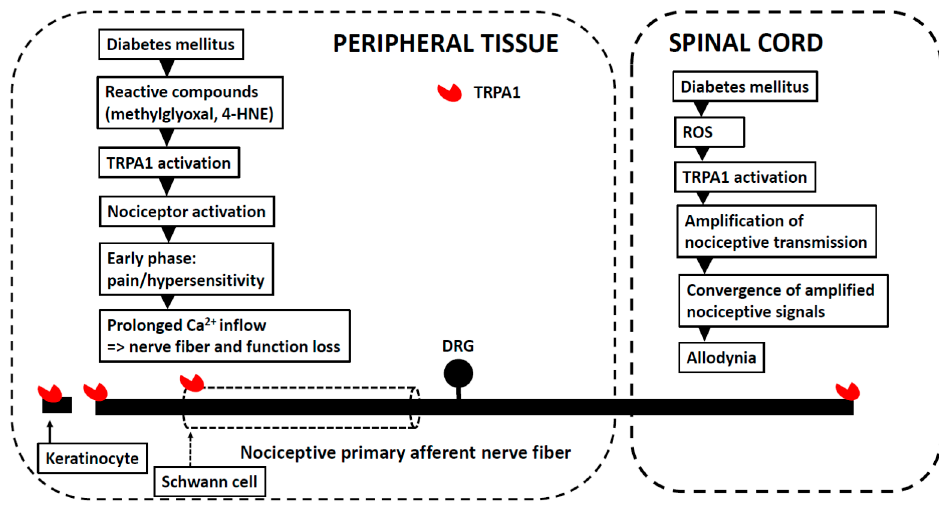
Figure 1. A schematic figure showing potential sites of action for TRPA1 in peripheral diabetic neuropathy (PDN). In the left (peripheral tissue), a possible cascade generated in diabetes that drives TRPA1 on nociceptive nerve endings, leading first to excitation that is followed by a loss of TRPA1-expressing nociceptive nerve fiber endings and their function. Note also that activation of TRPA1 on keratinocytes and/or Schwann cells might contribute to facilitation of pain behavior. In the right (spinal cord), a possible cascade that drives TRPA1 on central terminals of nociceptive primary afferent nerve fibers in diabetic animals, leading to enhanced transmission that, through central convergence of nociceptive signals to e.g., wide-dynamic range neurons, might contribute to allodynia. DRG: dorsal root ganglion.